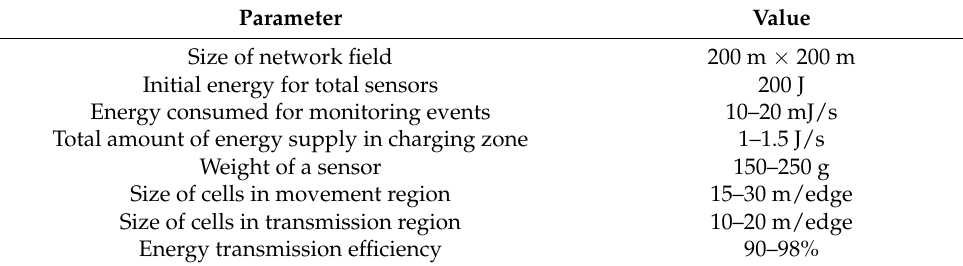
Table 2. Evaluation